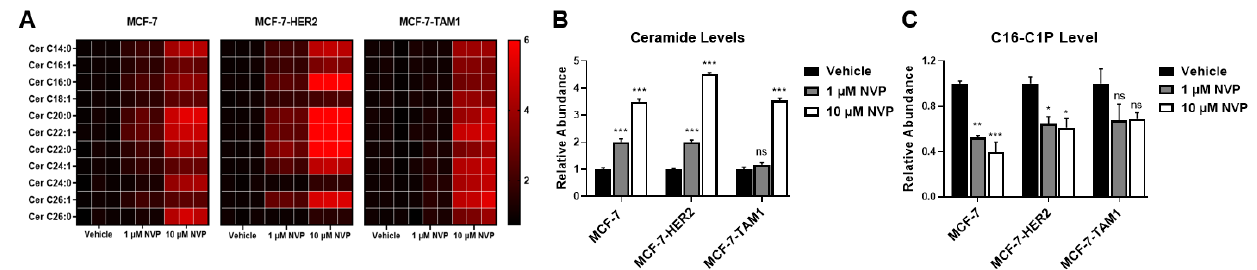
Figure 4. CERK inhibition induces similar changes in ceramides and C1P in all cell lines. ( A ) MCF-7, MCF-7-HER2, and MCF-7-TAM1 cells were treated with 1 µM and 10 µM NVP-231 for 48-h. Abundance of individual ceramide species in all cell lines was then measured relative to a vehicle-treated (DMSO) control for each cell line and presented as a heatmap. ( B ) Relative abundance of ceramides was calculated by dividing the abundance of ceramides in the NVP-treated groups by the average abundance of ceramides in vehicle-treated groups and data is presented as fold changes in a bar plot. ( C ) C16-C1P levels were assessed following 1 µM and 10 µM NVP-231 treatment for 48-h in all three cell lines. Data are represented as fold changes relative to C16-C1P levels in vehicle-treated control for each cell line. ns: not significant, * p < 0.05, ** p < 0.01, *** p < 0.001.